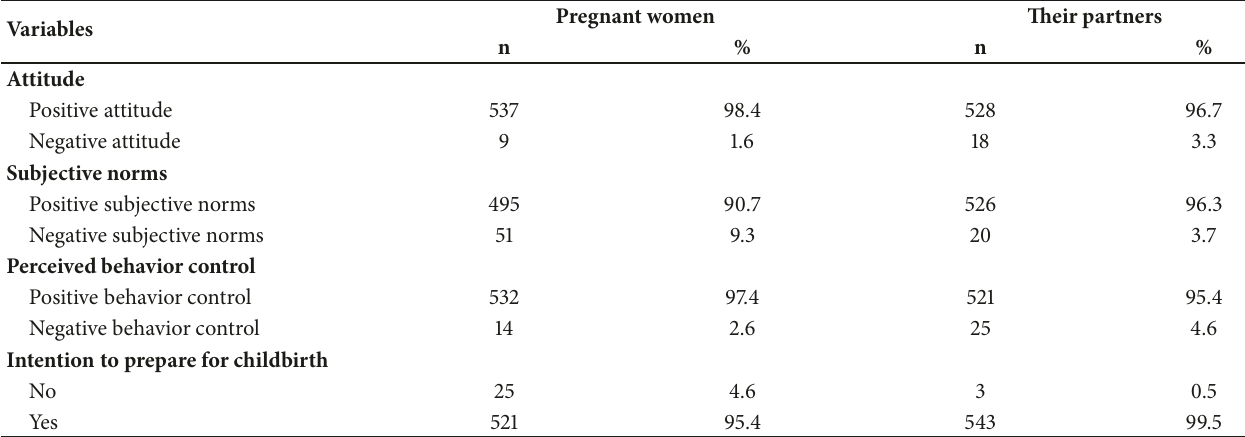
Table 2: Frequency distribution table on attitudes, perceived subjective norms, perceived behavior control towards birth preparedness, and birth preparedness intention among expecting